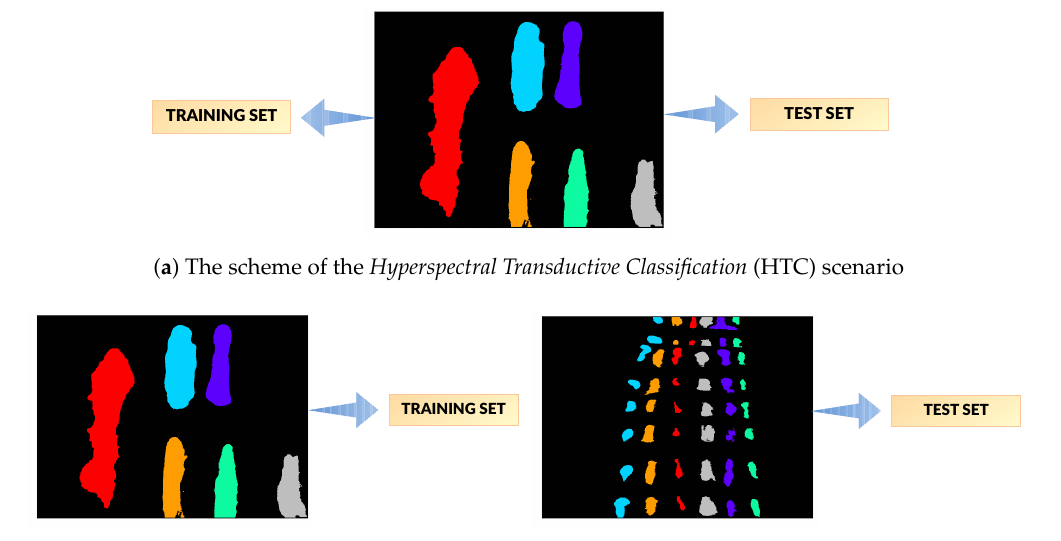
Figure 1. The visualization of the classification scenarios tested in our research. The first row presents the basic scenario in which a training and a test set come from the same image (HTC) while the second row shows the case when a test set is chosen from the another image than a training set (HIC). The HIC scenario is more useful from the point of view of forensic